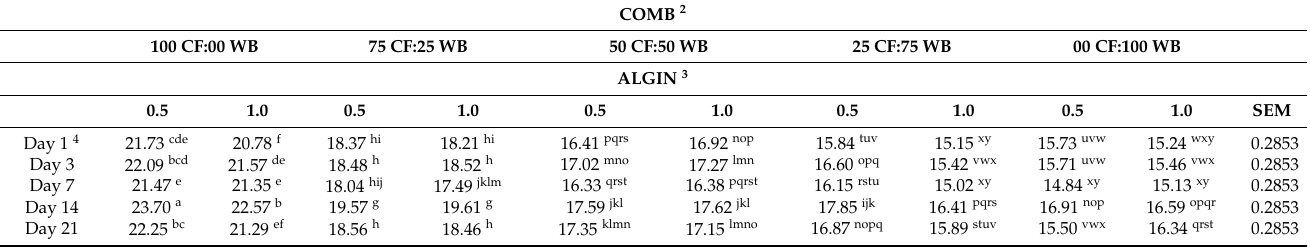
Table 4. Interactive effect of COMB × ALGIN × DAY on instrumental fresh color yellowness (b*) 1 of pet food formulations during a simulated retail display.